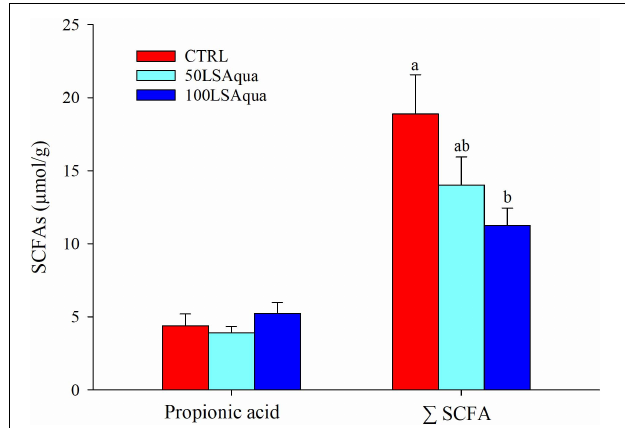
FIGURE 3 | Concentration of intestinal propionic acid and total short chain fatty acids ( (cid:54) SCFA) in fish fed CTRL (red bars), 50LSAqua (light blue bars), and 100LSAqua (dark blue bars) diets. Means + SEM are represented ( n = 10 fish per group). Significant differences (one-way ANOVA, Holm-Sidak post-test, P < 0.05) are indicated by different letters, which correspond to pairwise comparisons among dietary groups.